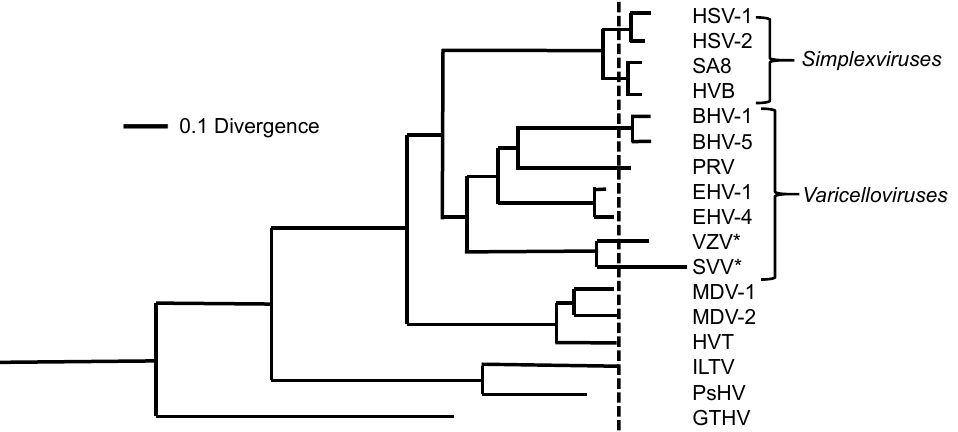
Figure 6. Phylogenetic tree of the alphaherpesviruses constructed based on amino acid alignment of six conserved herpesvirus genes [59]. SVV and VZV are denoted with an asterisk. Abbreviations: MDV-1, MDV-2, Marek’s disease virus; HVT, herpesvirus of turkeys; ILTV, infectious laryngotracheitis virus; PsHV, psittacid herpesvirus 1; GTHV, green turtle herpesvirus. Other abbreviations are indicated in the text. Reprinted from Virus Research [59] with permission from the